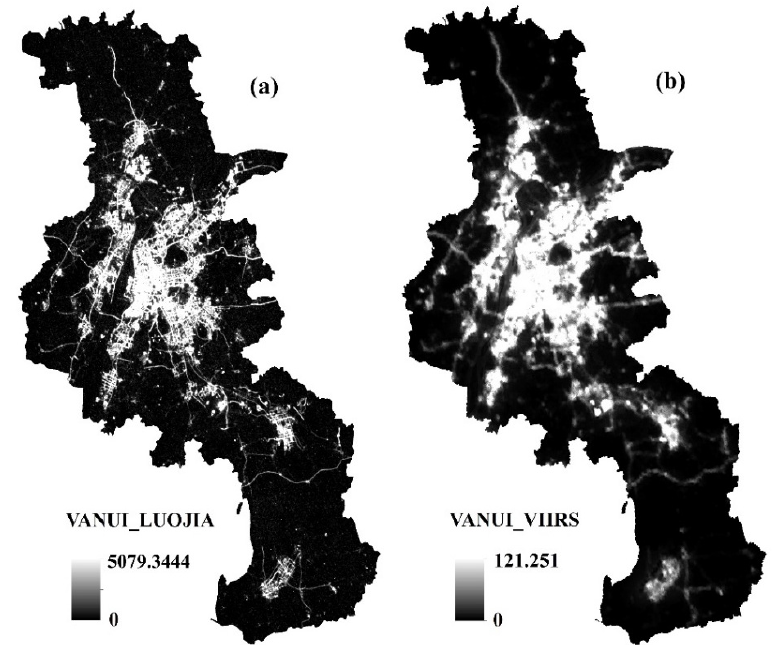
Figure 4. Spatial patterns of the urban indices: ( a ) Vegetation Adjusted NTL Urban Index (VANUI)_LUOJIA, derived from Luojia 1-01 data and Normalized Difference Vegetation Index (NDVI); ( b ) VANUI_VIIRS, derived from VIIRS data and NDVI.